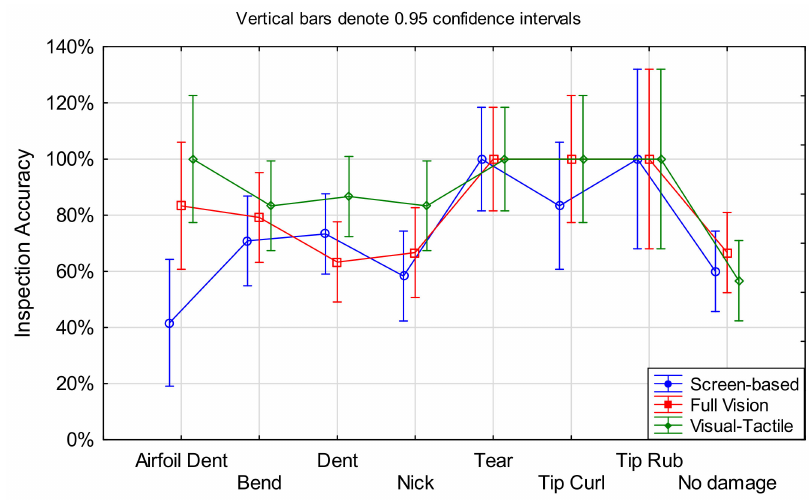
Figure 7. Mean plot of inspection accuracy by defect type for all inspection methods. Table 7. Inspection time and standard deviation of each inspection method by defect type (in seconds).